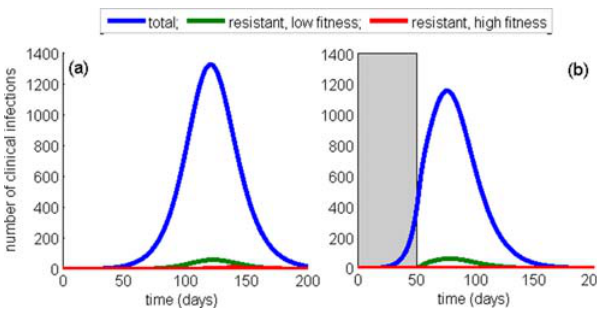
Figure 7. Time-courses of clinical infections with one day delay ~ 1 : 6 . Simulations in onset of treatment of indexed cases for R w 0 were run, when a single case infected with the wild-type virus is introduced into the susceptible population of size S 0 =100 000. Treatment in (a) is maintained at the optimal level (78%) for the entire course of the outbreak. Treatment in (b) is initiated at a 25% level for the first 50 days (shaded area), and then increased to 90% for the rest of the outbreak. All other parameters are the same as those used for simulations in Figure 2.